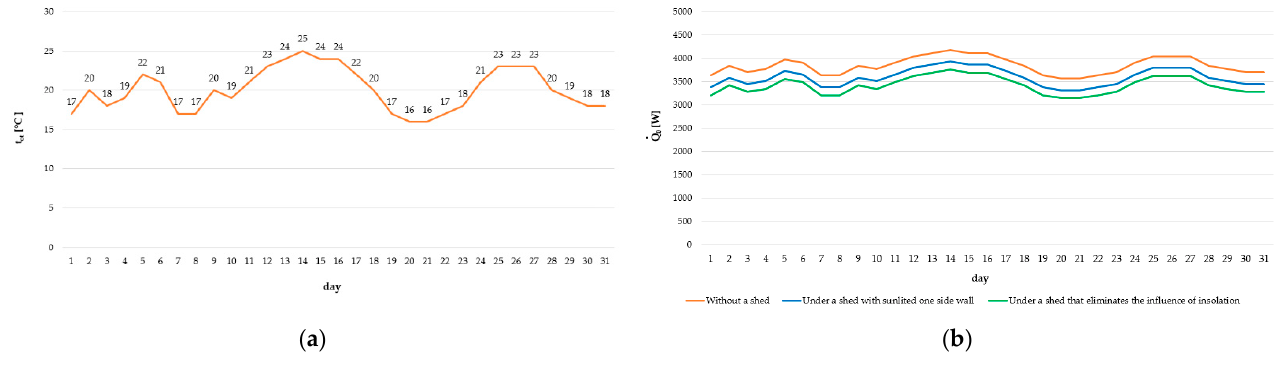
Figure 6. The average ambient temperature fluctuation in July 2021 in Szczecin city ( a ) and depend- ence of daily total heat gains of the refrigerated semi-trailer on the ambient temperature in particular days in July ( b ).